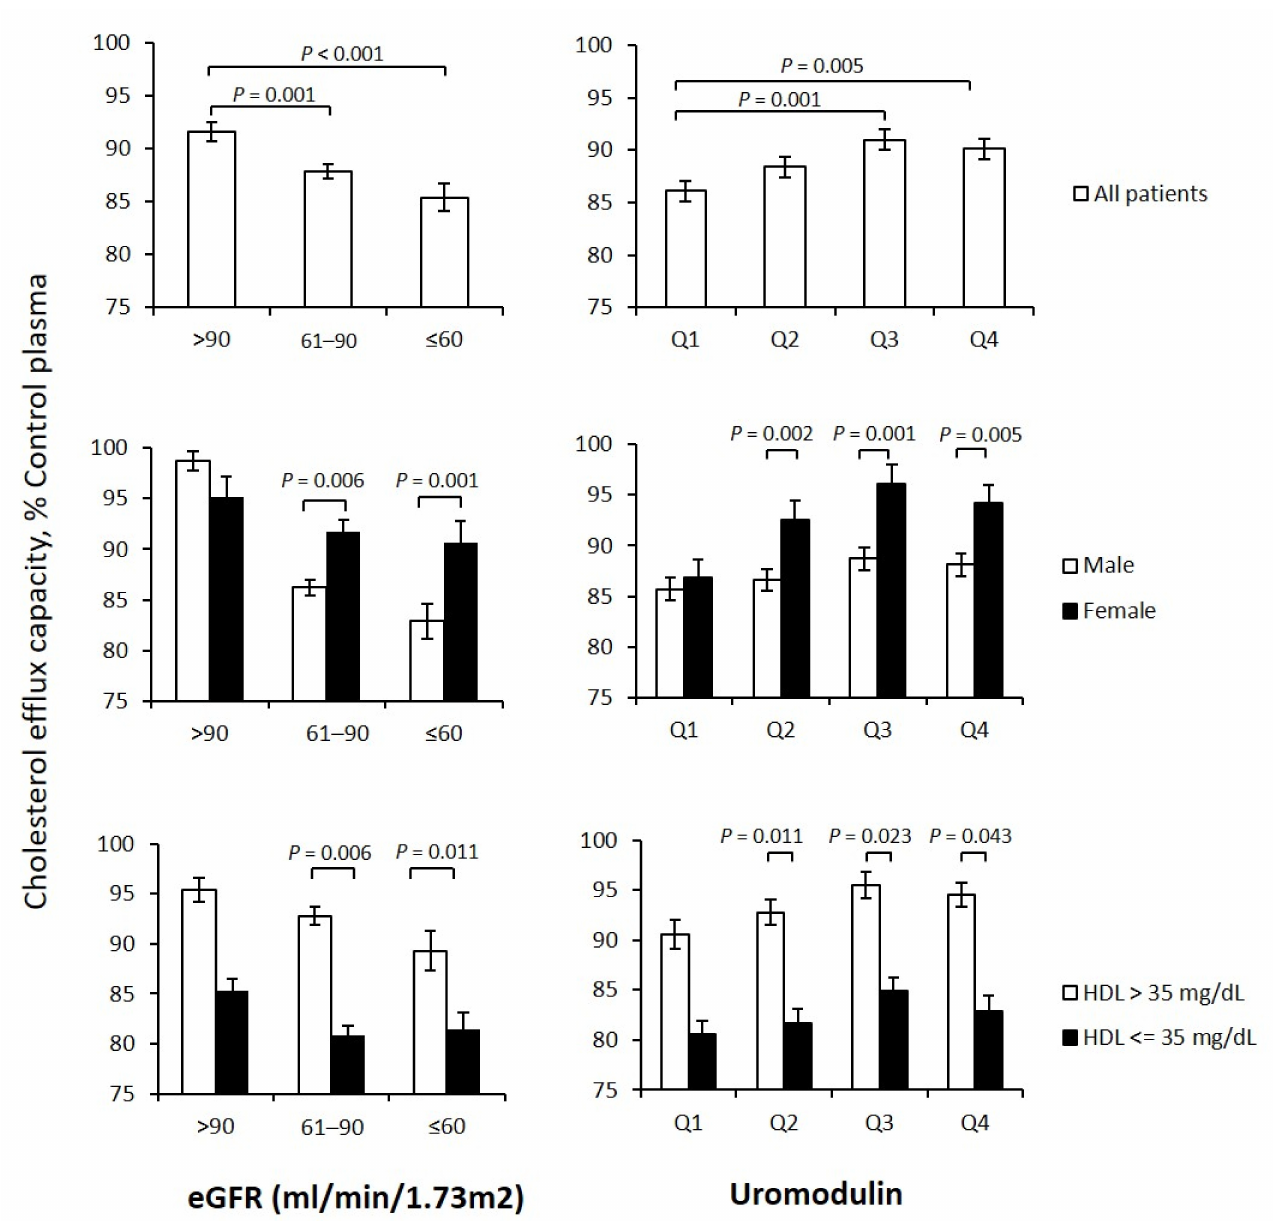
Figure 2. Association of kidney function parameters with cholesterol efflux. Multivariable-adjusted estimated marginal means of cholesterol efflux capacity in subgroups of participants of the LURIC study according to estimated glomerular filtration rate (eGFR, left panel) as well as uromodulin plasma concentration ( right panel). Subgroup analyses were performed corresponding to gender and HDL-C plasma concentration. Results are adjusted for age, gender, use of statins, CAD, BMI, diabetes mellitus, glycosylated hemoglobin, smoking, LDL/HDL cholesterol, triglycerides, and